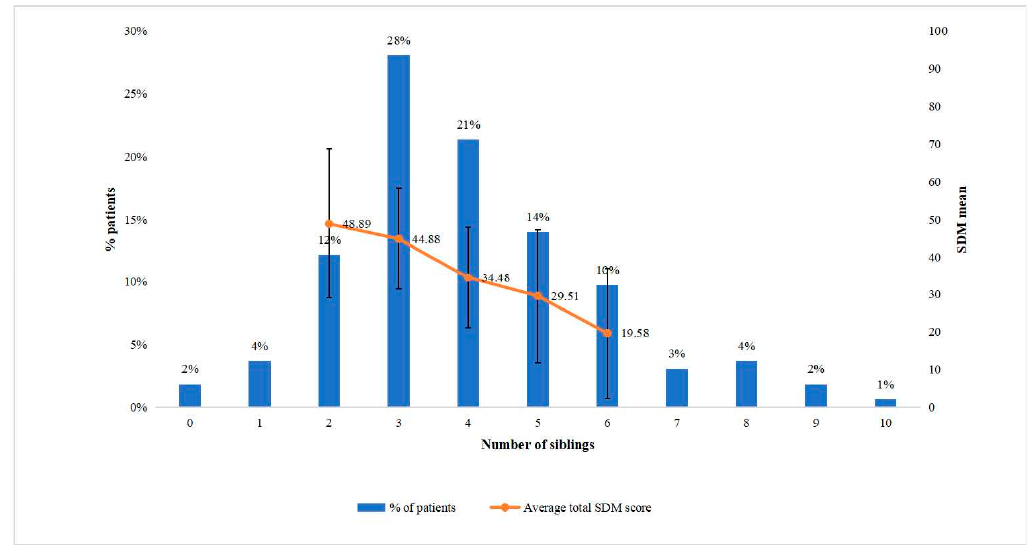
Figure 4. SDM scores and number of siblings. Notes: 95% confidence intervals were not available when the percentage of patients was lower than 5.